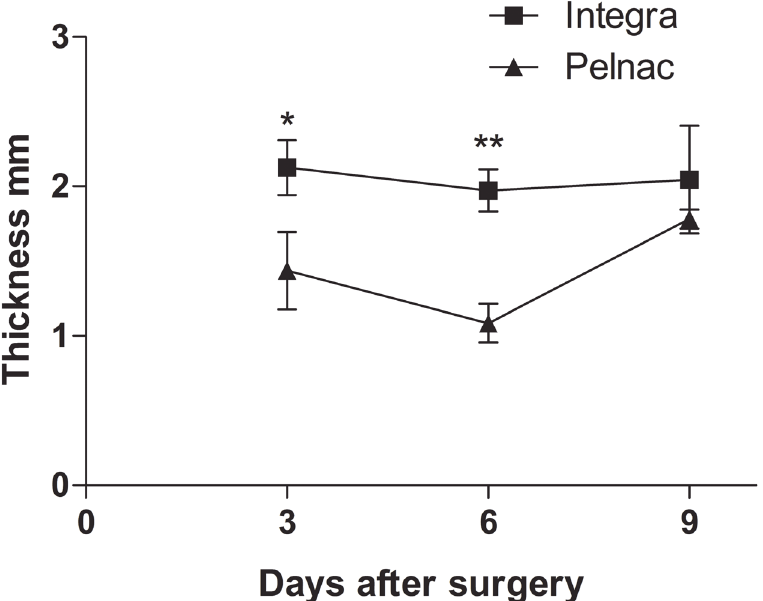
Fig 2. Analysis of the granulation tissue. The average thickness was measured in μ m in the large portion of the granulation tissue of each field and results are expressed as the mean ± SEM of 5 animals. * p = 0.03 and ** p = 0.001 vs . Pelnac by two-tailed unpaired t-test.